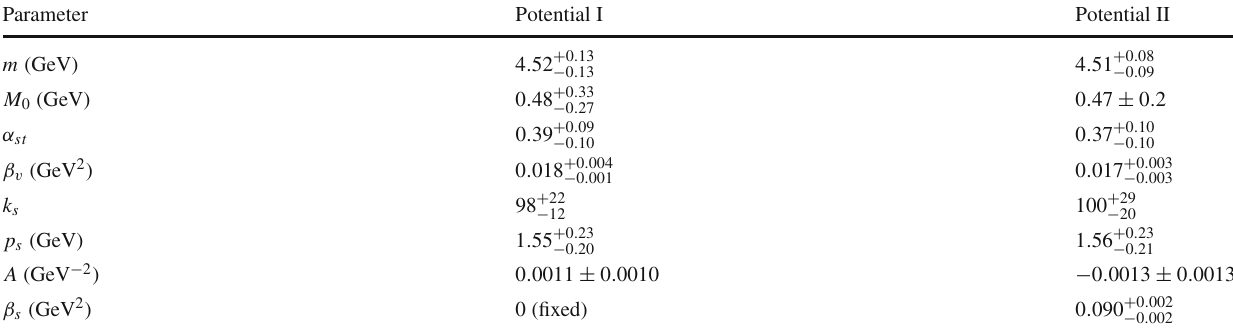
Table 2 Fit parameters for both potentials. Error bars are reported at 1 σ (68%) CL and take into account all the correlations among the parameters Parameter